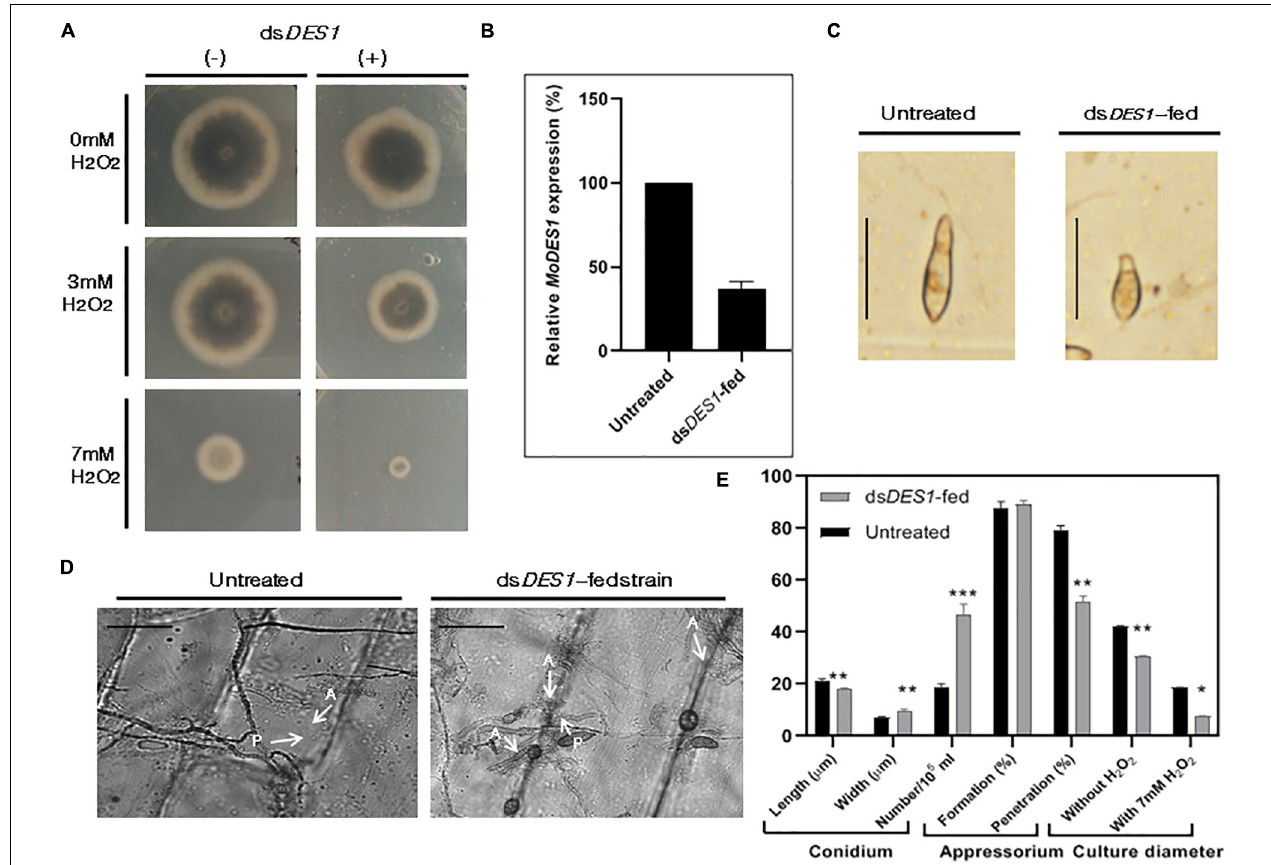
FIGURE 4 | Assessment of ROS-scavenging activity, morphological traits, and target transcripts in the in vitro ds DES1 - fed strain. (A) Reactive oxygen species (ROS) sensitivity assay of ds DES1 -fed and untreated strains of wild-type B157. The ds DES1 -fed and ds DES1 -untreated strains were grown on CM plates with 0, 3, and 7 mM H 2 O 2 , and average growth diameter of the cultures was recorded from 5- to 10-day-old plates in triplicates. The experiment was repeated twice. (B) Relative MoDES1 expression in the ds DES1 -fed strain with respect to the untreated strain 72 hpt. The reactions were set up in triplicates, and MoACTIN was used as internal control. (C) The dominant morphological deformity in a major fraction of conidia isolated from the ds DES1 -fed strain. For size reference, a 20- µ m scale has been used. (D) Penetration potential of germinated appressoria among the untreated and ds DES1 -fed strain, on onion epidermal peel. A 50- µ m scale has been used for size- reference. Three replicates were used, and at least 50 conidia were assessed in each category. (E) Comparison of phenotypic parameters between untreated and ds DES1 -fed strain. Error bars represent standard deviation, and *, **, *** denote statistical significance at the P ≤ 0.05, P ≤ 0.01, and P ≤ 0.001 level,